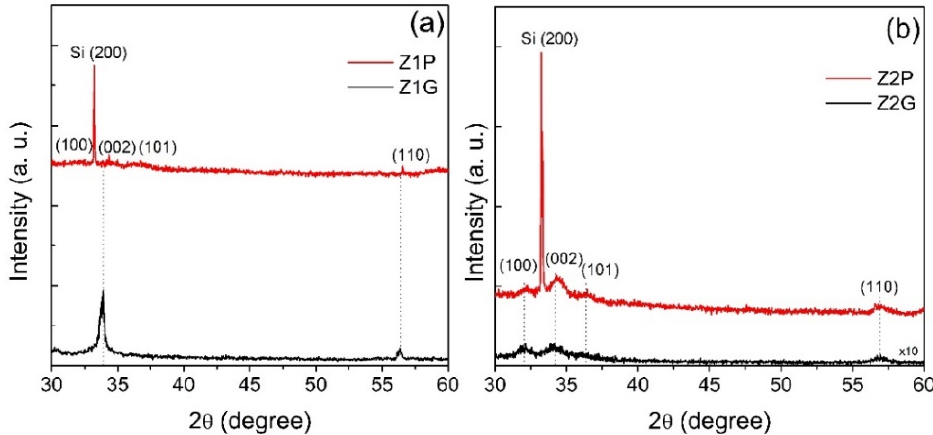
Figure 2. XRD patterns of ZnO films deposited by the sol–gel spin coating ( a ) and USP ( b ) methods on glass (Z1G, Z2G) and macroporous silicon (Z1P, Z2P) substrate.